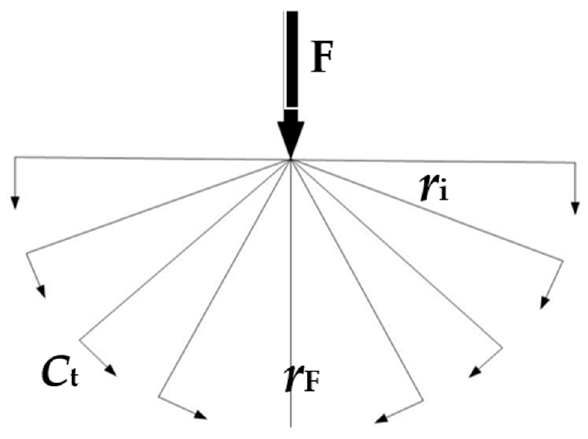
Figure 2. Directions of the transverse waves.